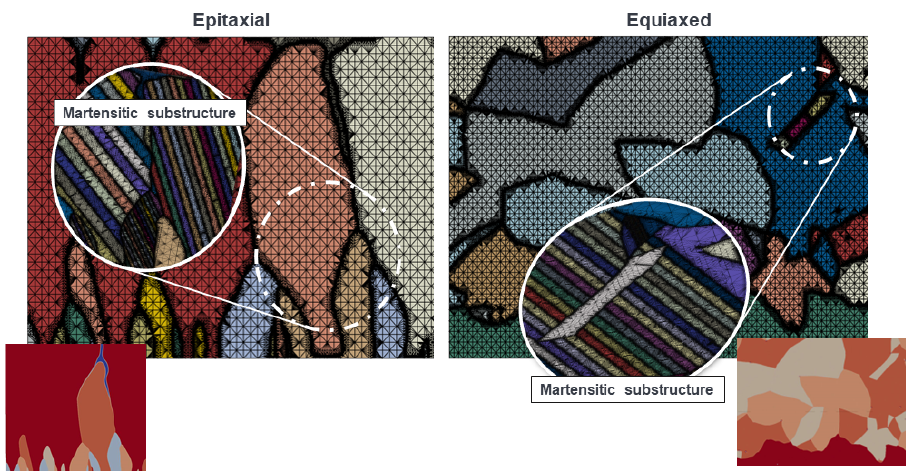
Figure 5. Generation of a finite element mesh for micromechanical modeling of Ti-6-4 with a lath martensite substructure. Epitaxial structure is on the left, equiaxed structure is on the right.